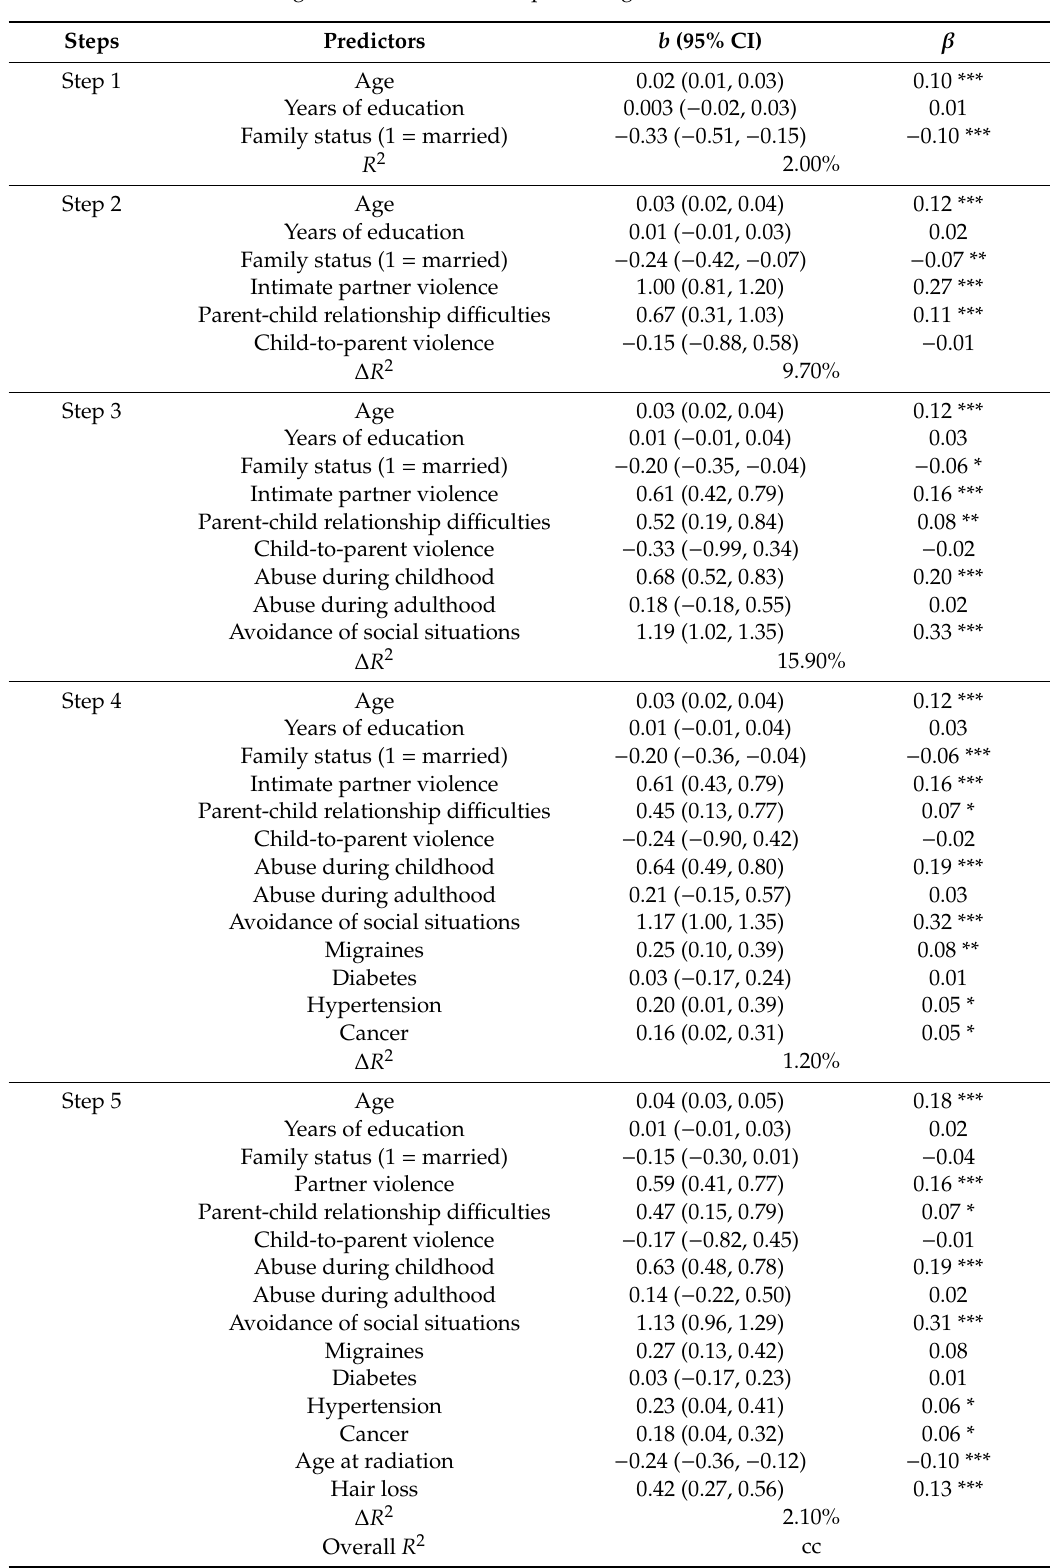
Table 4. Regression coe ffi cients for predicting women’s mental